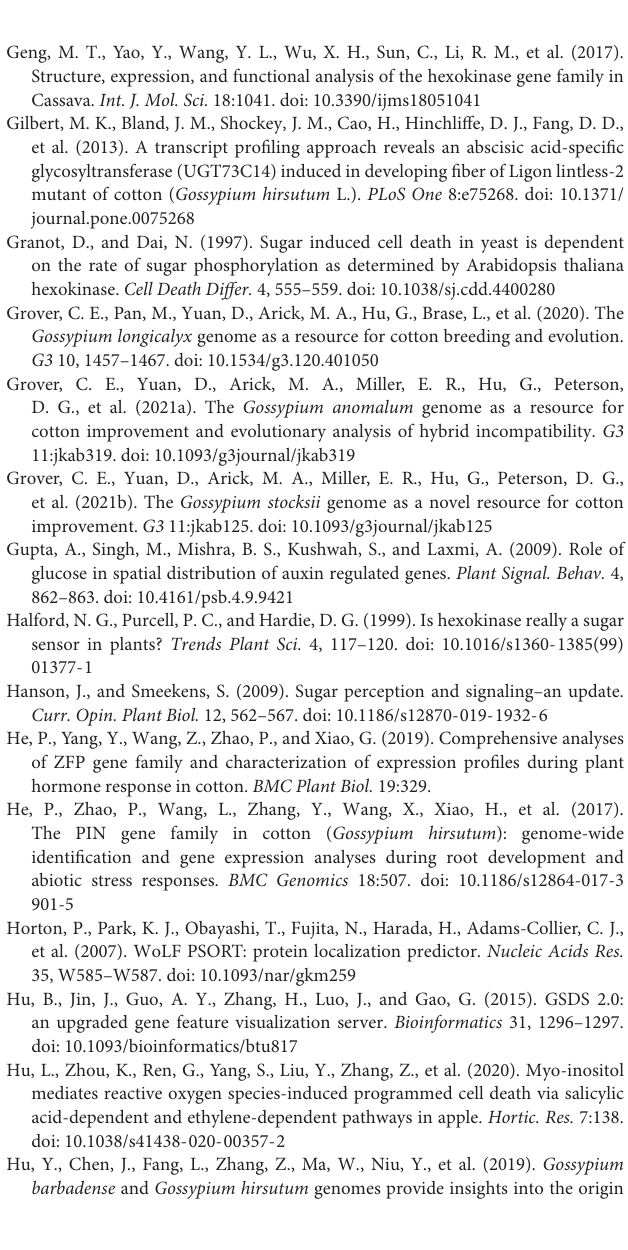
with 1,000 bootstraps. (B) Gene structure. The blue oval and black lines represent exons and introns, respectively. Supplementary Figure 4 | Amino acid alignment analysis of GhHXKs. The red lines indicate the regions with different functions. The red arrow directs the eight conserved amino acids (counting the amino acid residues based on GhHXK2, the eight amino acids are Asp-106, Thr-110, Lys-196, Asp-231, Gly-253, Asp-438, Gly-440, and Ser-473), which are the active residues of hexokinases (HXKs). The alignment was performed with ClustalW and displayed by GeneDoc. Supplementary Figure 5 | Distribution of the HXK family genes in plantae. The phylogenetic tree of 18 plant species was shown on the left (A) . The genome size (B) and number of HXK genes (C) found in each genome are indicated on the right. Supplementary Figure 6 | Expression heatmap of the GhHXKs at various tissues (stamen, anther, seed, fiber, ovule, petal, calycle, torus, leaf, stem, root, cotyledon, stigma, and